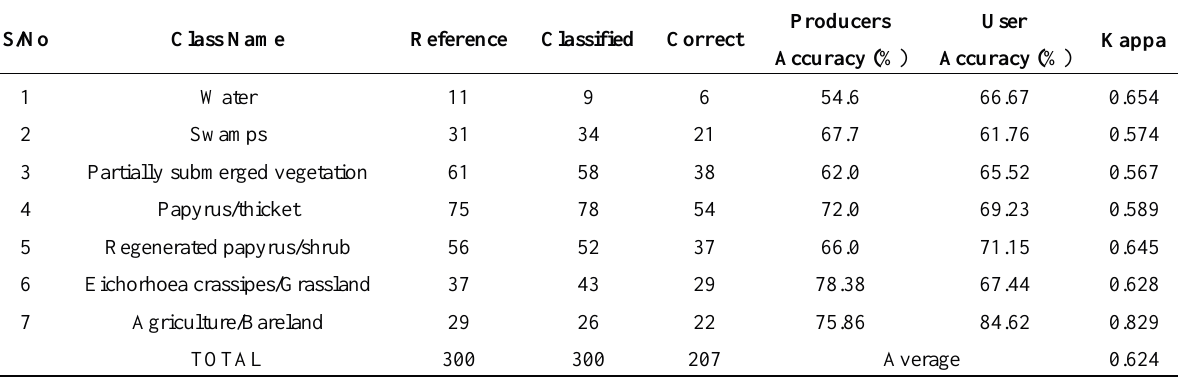
Figure 9. Vegetation map of Mara wetland floodplain showing seven classes of vegetation types. Table 4. Supervised Classification Accuracy